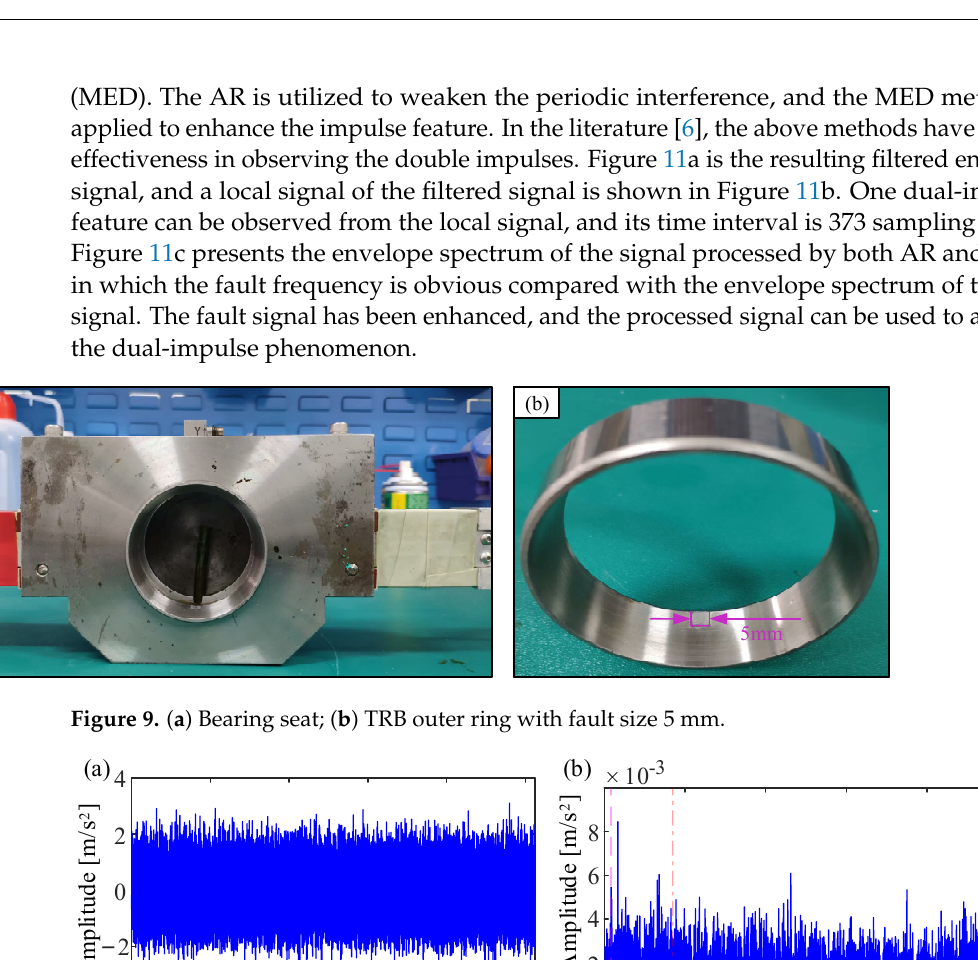
Figure 9. ( a ) Bearing seat; ( b ) TRB outer ring with fault size 5 mm.